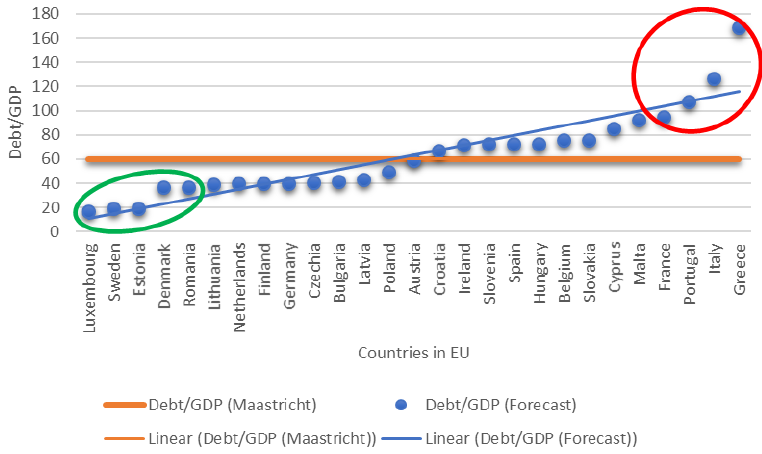
Figure 5. Average values of the forecast debt-to-GDP ratio for the period 2023–2024, Ver. 2.0 (8 indicators). Source: authors’ calculations.